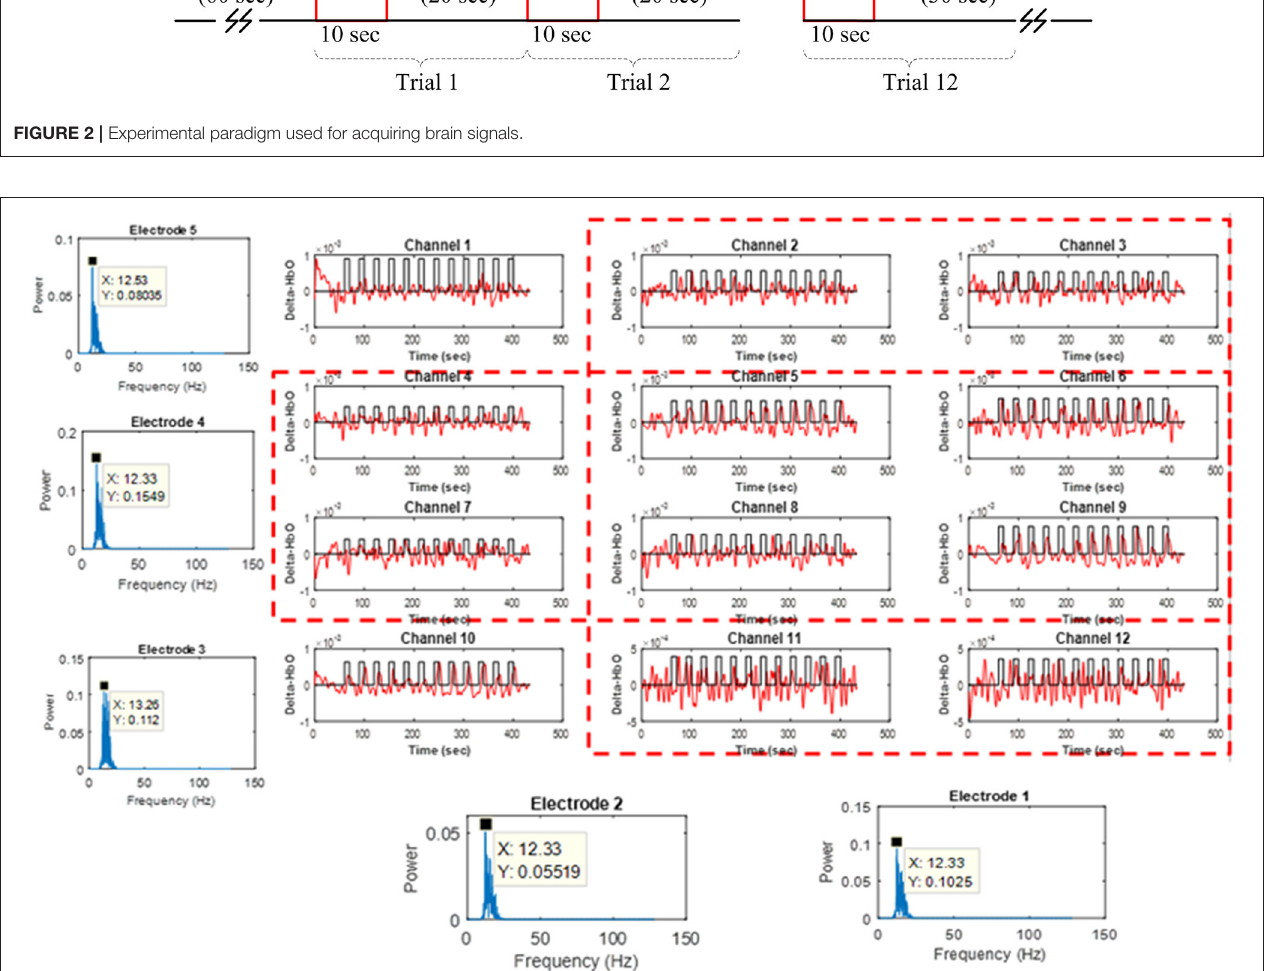
FIGURE 3 | Cross-checking strategy for finding active fNIRS channels using EEG electrodes showing the highest power for 1s, in which EEG electrodes are placed vertically and horizontally (Sub. 1, fNIRS channels 13–36 are